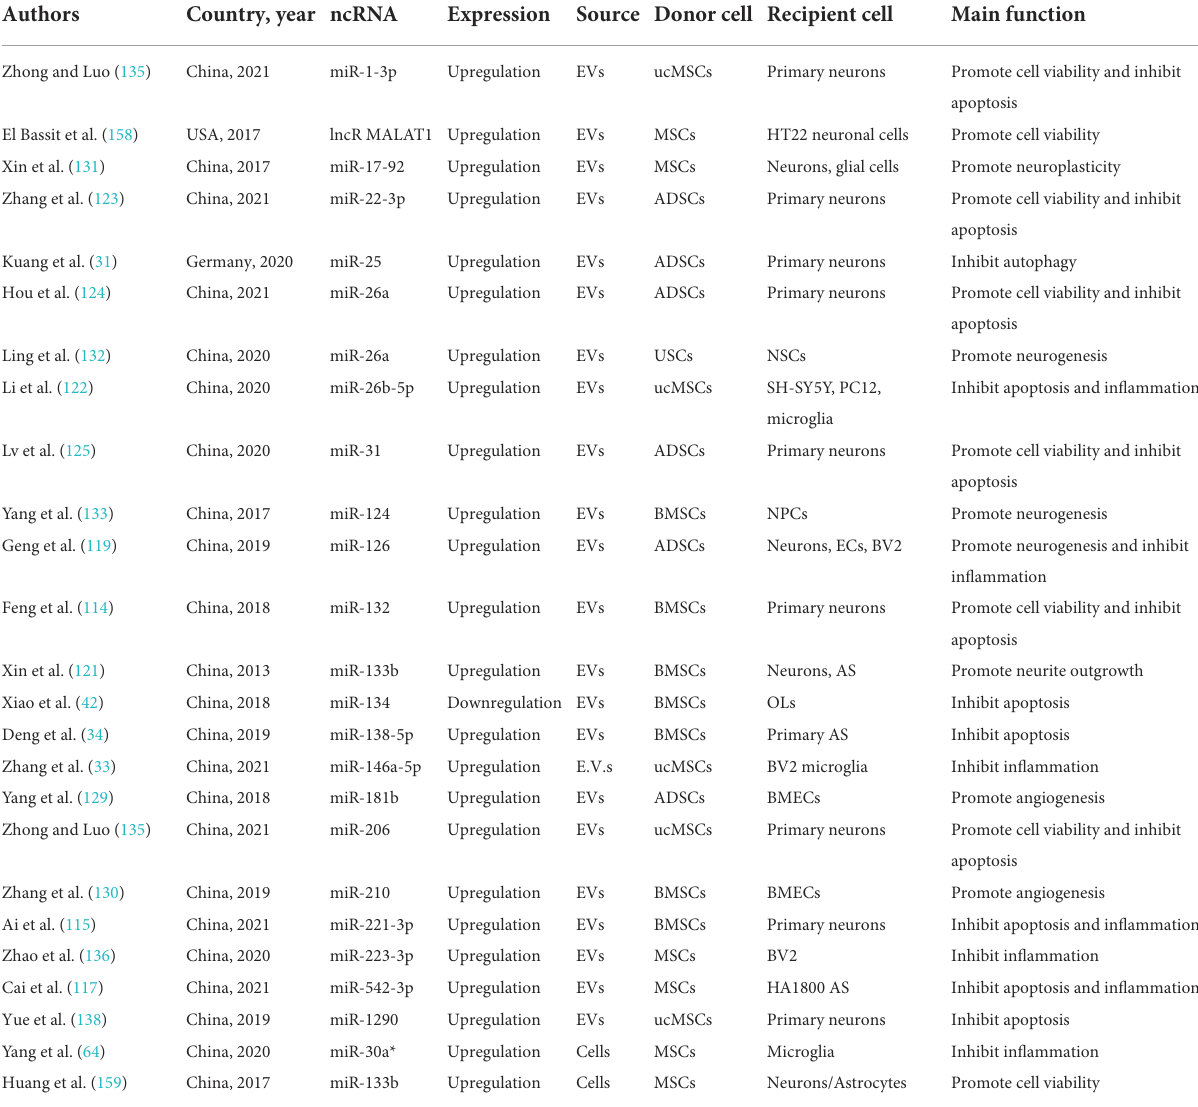
TABLE 2 Preclinical studies evaluating the effect of MSC-non-coding RNA on treating ischemic stroke.